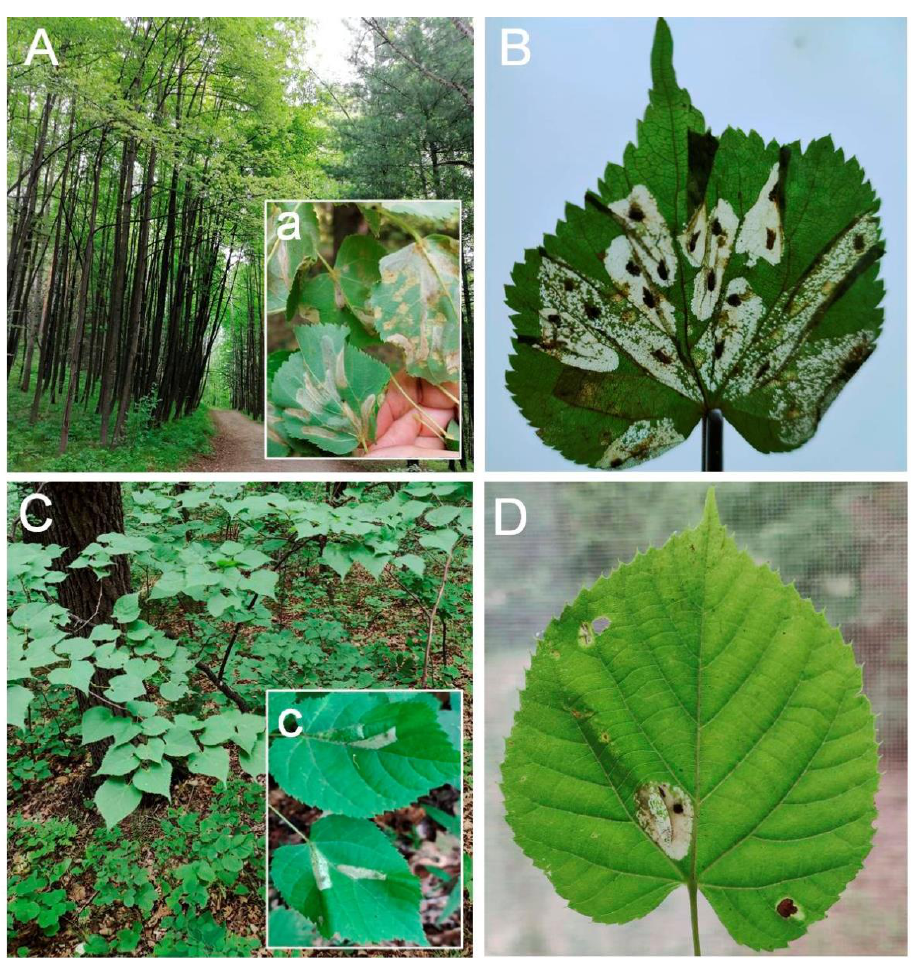
Figure 1. The studied localities in the Russian Far East and in western Siberia. MTS — the botanical garden of the Mountain-Taiga Station, Gornotaezhnoe, Ussuriysk District, Primorskiy Territory; CSBG — the Central Siberian Botanical Garden, Novosibirsk.